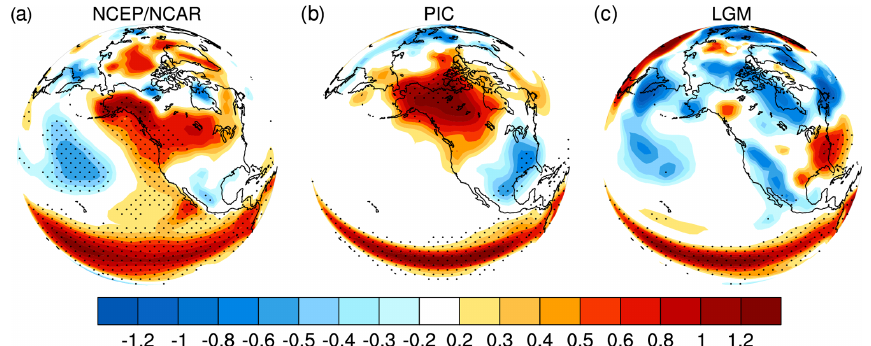
Figure 9. DJF SAT regressions on the Nino3.4 index in the NCEP/NCAR reanalysis and PMIP2 CCSM3 simulations. (a) NCEP/NCAR reanalysis, (b) PIC and (c) LGM. The regression value of 0.21 corresponds to the 95% confidence level for 30-year regressions.